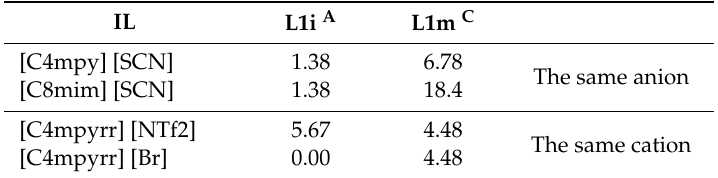
Table3. Three-dimensional(3D)descriptorscalculatedforanionsandcationsafterseparateoptimization of ions. Descriptors in the table form equation of model M2.